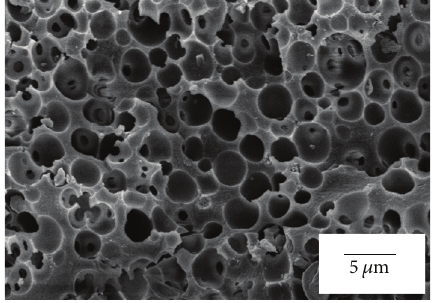
Figure 2: SEM photograph of L-TRPM-imprinted polymer.